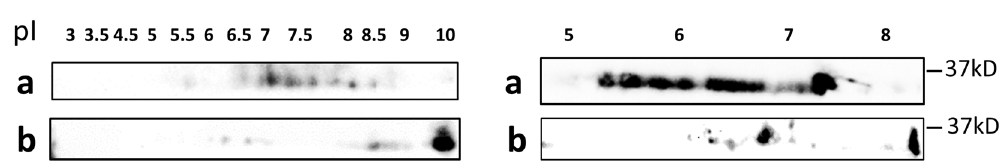
Figure 4. gNAC-β isoform spots from testis ribosomes. (a) Before and ( b ), after alkaline phosphatase treatment, showing spots vanishing or shifting to a region with a higher pI. Full blots in Expanded files 2, 3 in